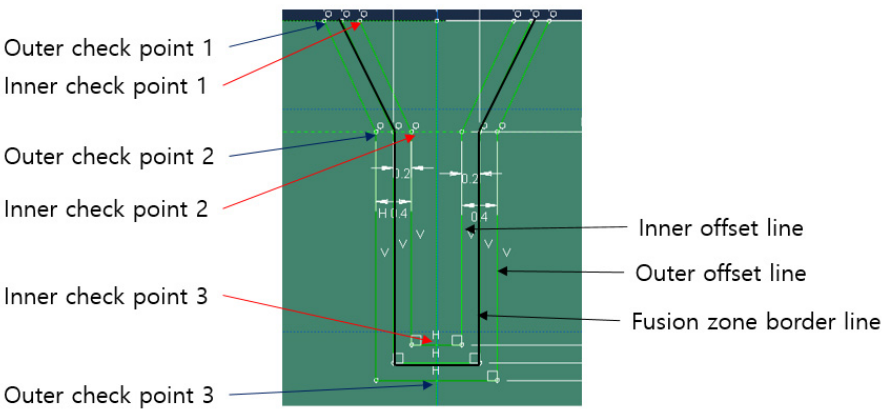
Figure 7. Fusion zone border line and temperature check points.